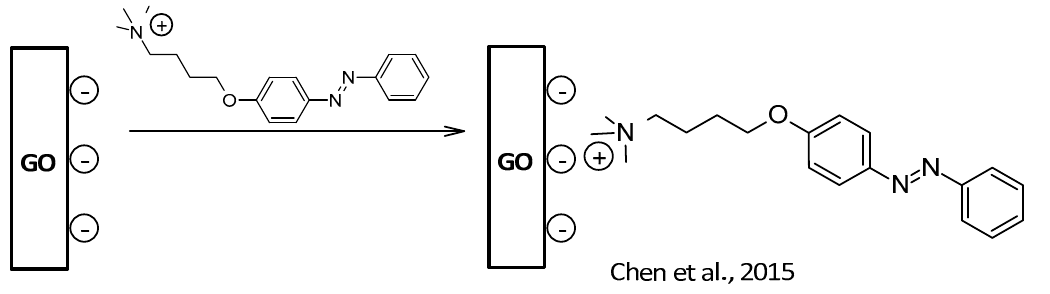
Figure 8. Electrostatic functionalization of GO [100].